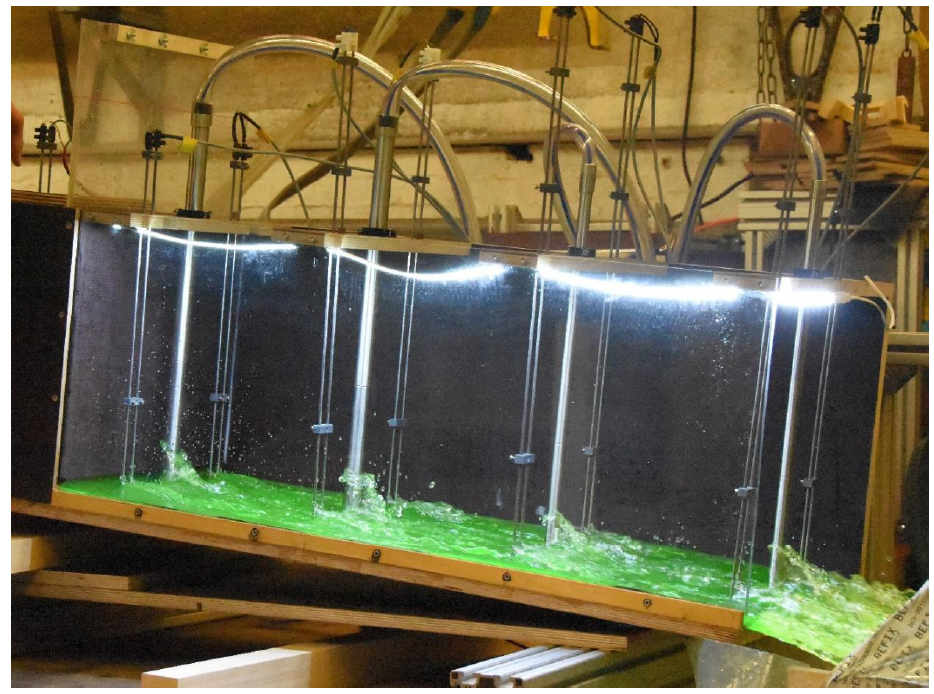
Figure A2. Outflow test with an inclination of 5° and initial water depth of 0.15 m in the